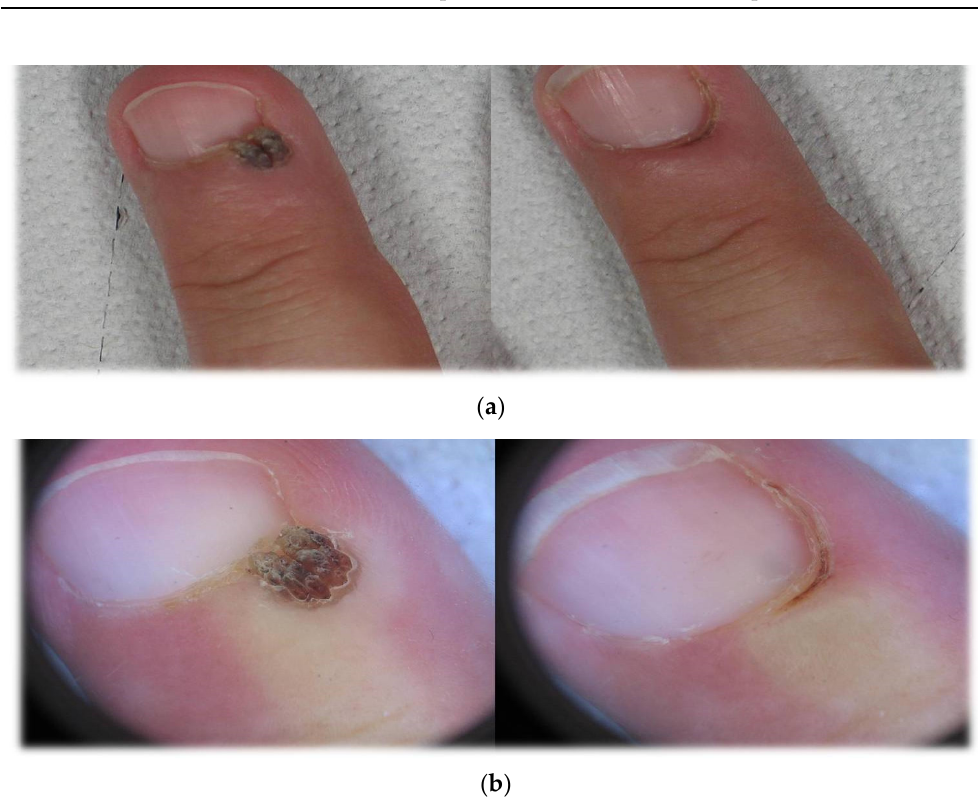
Figure 2. ( b ) Patient n. 20 before treatment (left) and 1 month after treatment (right) dermatoscopic view; ( a ) patient n. 20 before treatment (left) and 1 month after treatment (right).